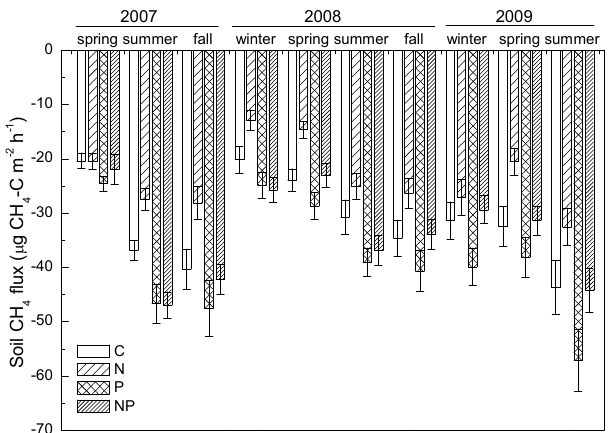
Figure 4. Seasonal pattern of soil CH 4 uptake (April 2007 to September 2009). Bars 2 Fig. 4. Seasonal pattern of soil CH 4 uptake (April 2007 to Septem- indicate ± 1 SE, N = 5. Spring form April to June, summer from July to September, 3 ber 2009). Bars indicate ± 1SE, N=5. Spring from April to June, summer from July to September, fall from October to December fall from October to December and winter from January to March. 4 and winter from January to